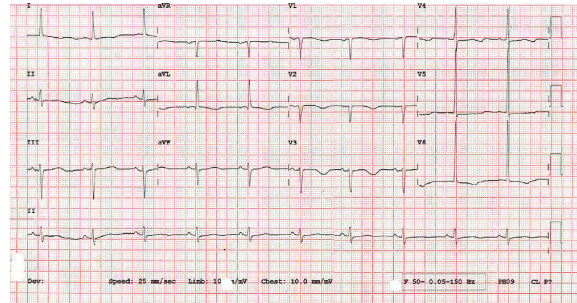
Figure 1: Rhythm strip recorded during the episodes of syncope showing polymorphic VT, preceded by sinus rhythm with atrial ectopic beats.